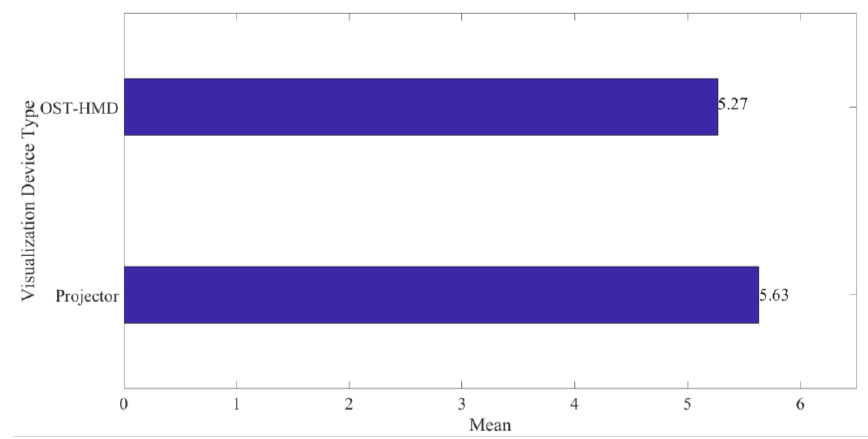
Figure 12. Visualization Device Type against Average Usefulness.